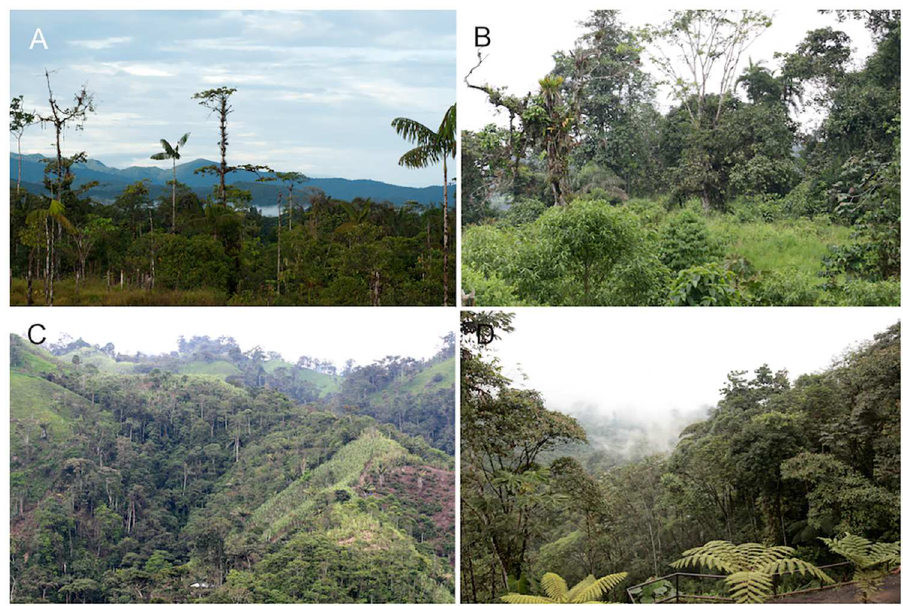
Fig 8. Habitat of Pristimantis ornatissimus sensu stricto (A, B, D) and P . ecuadorensis sp. nov (C).